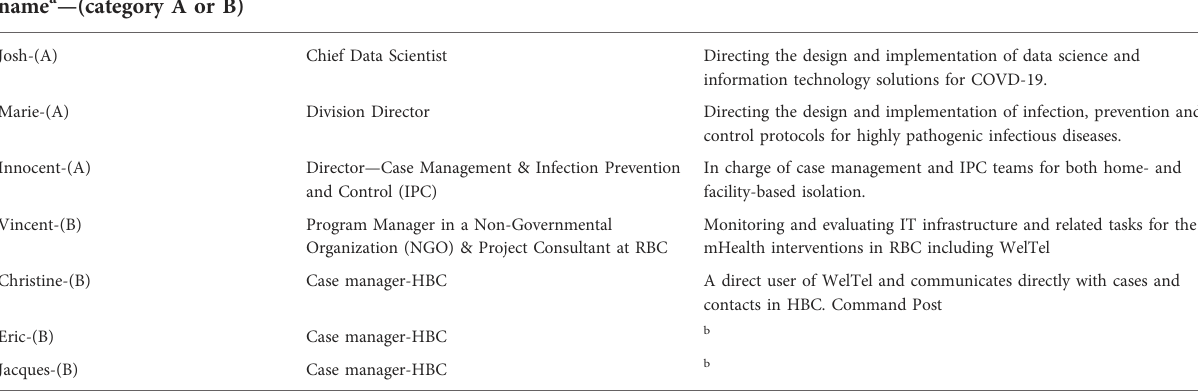
TABLE 1 Summary of